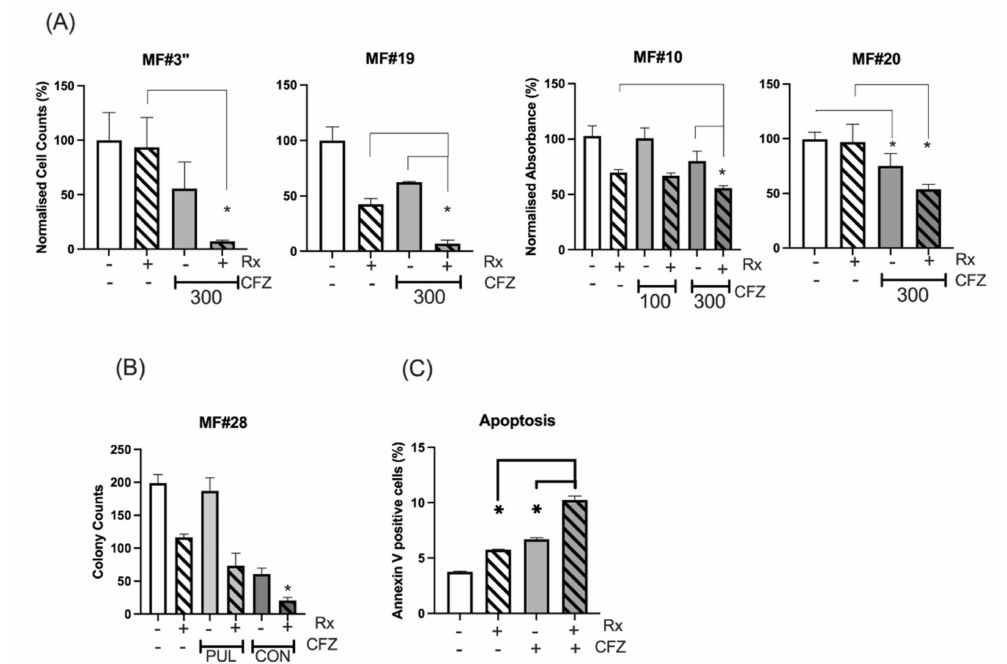
Figure 4. Continuous and pulsed exposure of MF CD34 + cells to CFZ. ( A ) CFZ 1h-pulsed exposure potentiated the ruxolitinib effect on the inhibition of cell proliferation or viability of MNC from MF#3”, MF#19 and MF#20 and CD34 + cells from MF#10. The cell count (MF#3” and MF#19) and the MTS assay measurement (MF#10 and MF#20) was performed at 72 h (MF19, MF#20 and MF#10) and at 48 h (MF#3) from pulsed exposure (refer to Figure S3 for experiment description). The Y axis represents the normalised cell counts (MF#3 and MF#19) or normalised absorbance (MF#10 and MF#20) expressed as percentage of the control. Cell viability was significantly reduced with 300 nM 1h-pulsed CFZ compared to untreated control ( p value < 0.05). The reduction of cell viability by ruxolitinib was also significant ( p value < 0.05) except for MF#3” and MF#20 (* represents p value < 0.05). Please see the p values of